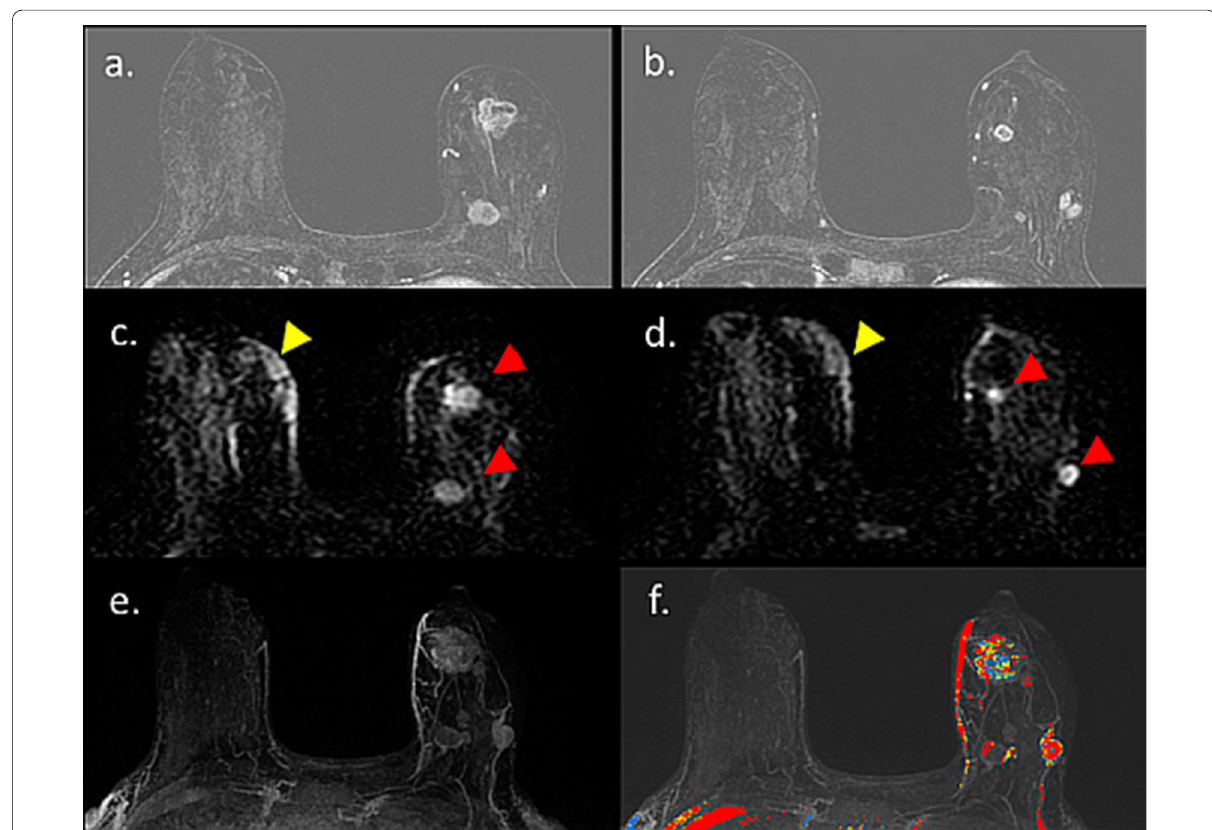
Fig. 17 MRI of multi‑centric IDC during lactation. MRI of a 40‑year‑old PABC patient (lactating for 18 months) is presented. The woman presented with a palpable left breast mass and was referred to pre‑operative MRI upon IDC diagnosis. Note : Several multifocal tumor foci are shown on the subtracted DCE MRI of the left breast (red arrow heads), surrounded by a moderate BPE (grade 2) ( a , b ). In agreement, diffusion weighted images (b 700) revealed restricted tumor regions ( c , d ), though incomplete fat saturation artifacts are also presented on the right breast (yellow arrow = heads). The entire multifocal tumor distribution could be further appreciated on MIP images of DCE and CAD ( e and f ,